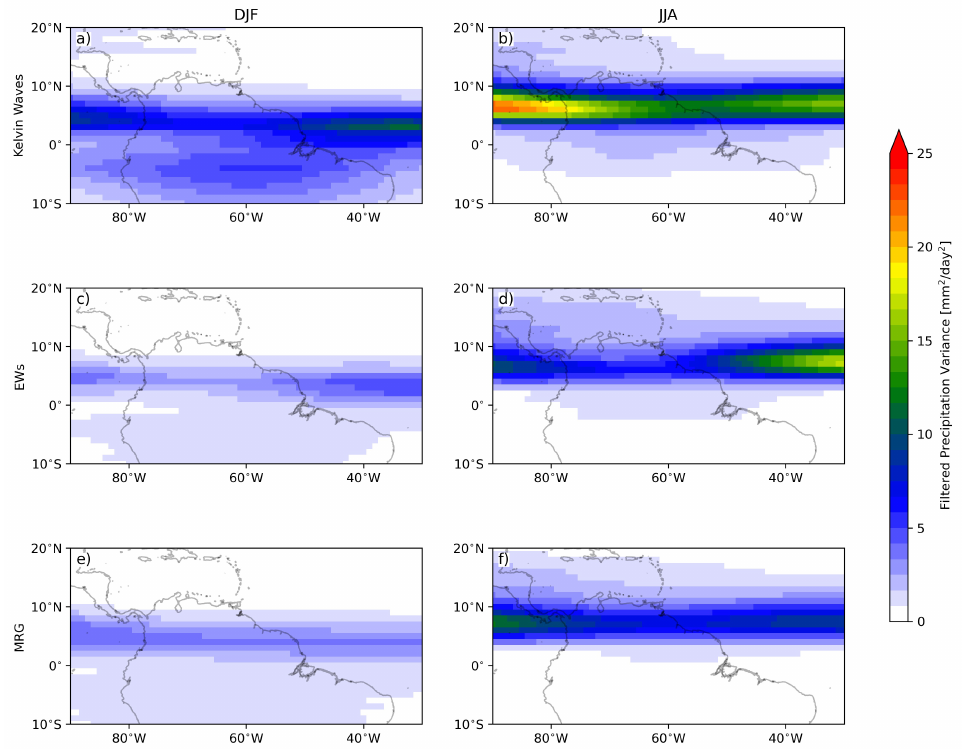
Figure 3. Geographical distribution of ERA5 precipitation variance for the seasons DJF ( left column ) and JJA ( right column ) for ( a , b ) Kelvin waves, ( c , d ) easterly waves (EWs), and ( e , f ) mixed Rossby- gravity (MRG)